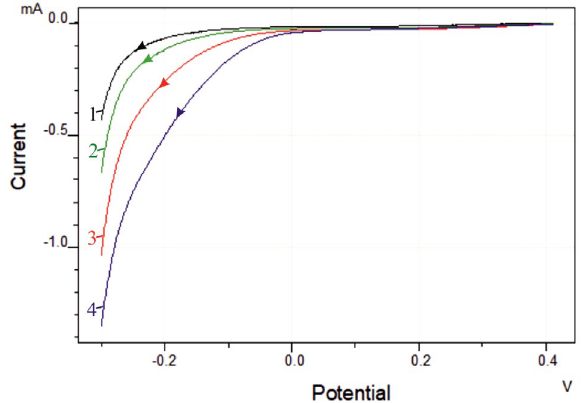
Fig . 3 . (a) lgi k as a function of 1/T, (b) Activation energy as a function of po-